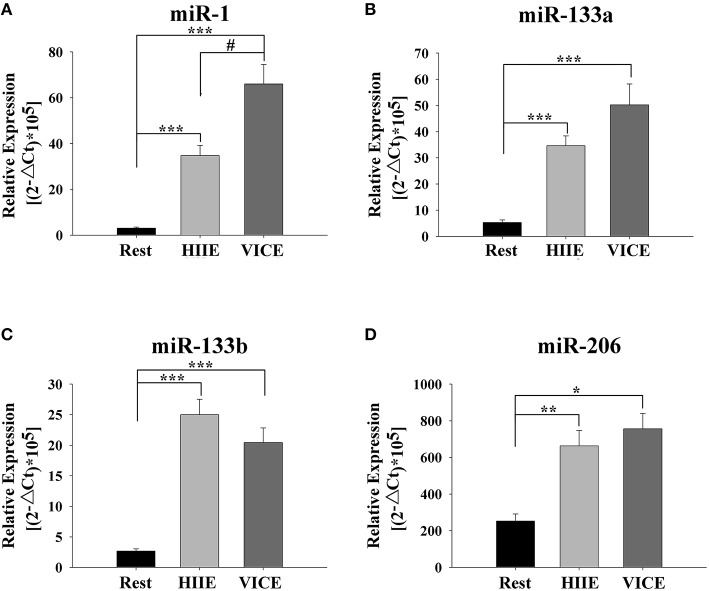
Muscle-specific c-miRNAs are elevated after high intensity interval exercise and vigorous intensity continuous exercise. Immediately after high-intensity interval exercise (HIIE) and vigorous-intensity continuous exercise (VICE), plasma levels of miR-1 (A), miR-133a (B), miR-133b (C), miR-206 (D) were significantly increased. Compared to the HIIE, plasma level of miR-1 in the VICE was increased significantly. c-miRNA levels are displayed as relative levels based on the formula (2−▵Ct×105). Values represent the mean ± SEM obtained from 26 subjects. *Indicates differences compared to Rest, P < 0.05; **Indicates differences compared to Rest, P < 0.01; ***Indicates differences compared to Rest, P < 0.001; #Indicates differences compared to VICE, P < 0.05.